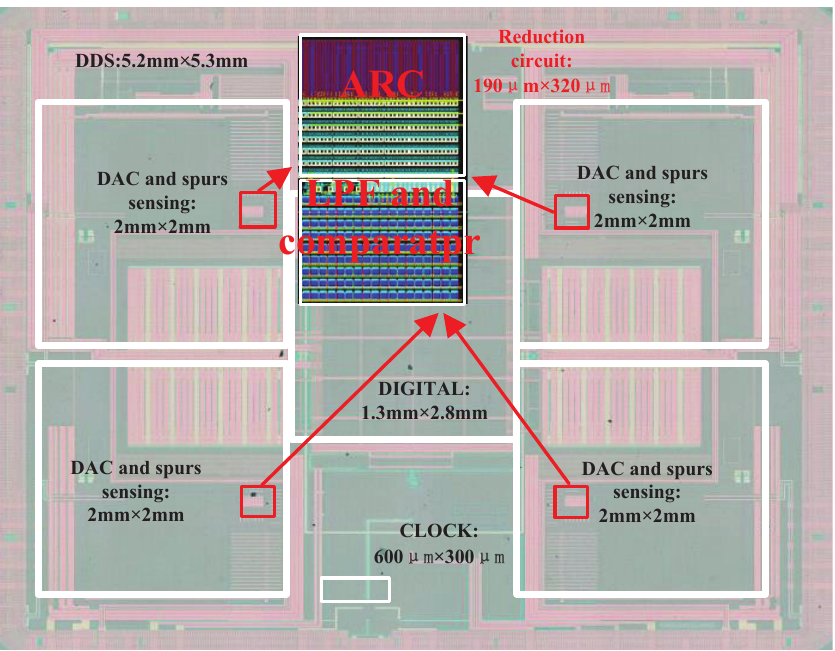
Figure 9. Chip microphotograph of the